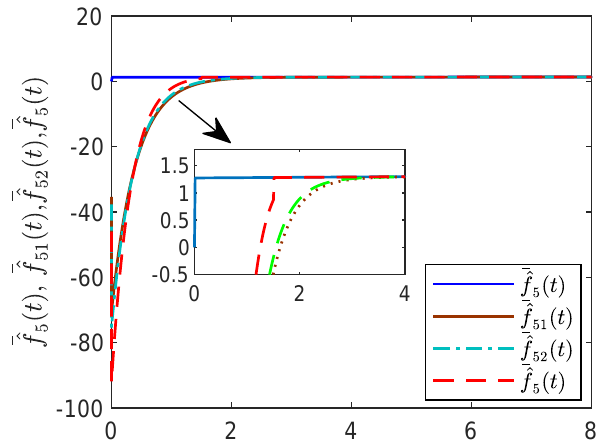
Figure 16. States (cid:107) r (cid:107) with and without observer.